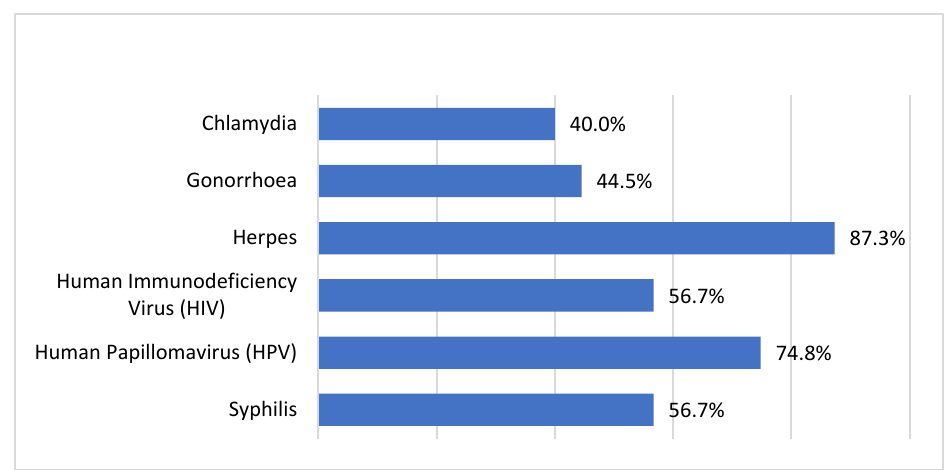
Figure 2. Respondents’ knowledge of the common STIs transmissible through oral sex.